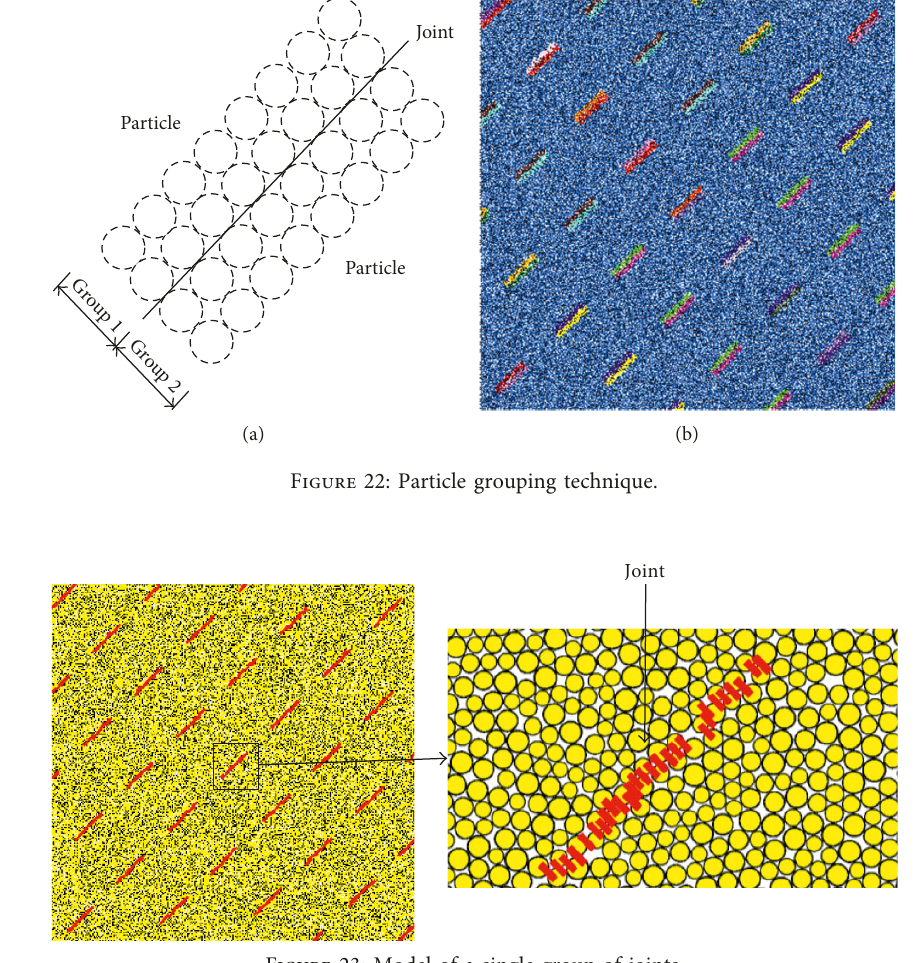
Figure 23: Model of a single group of